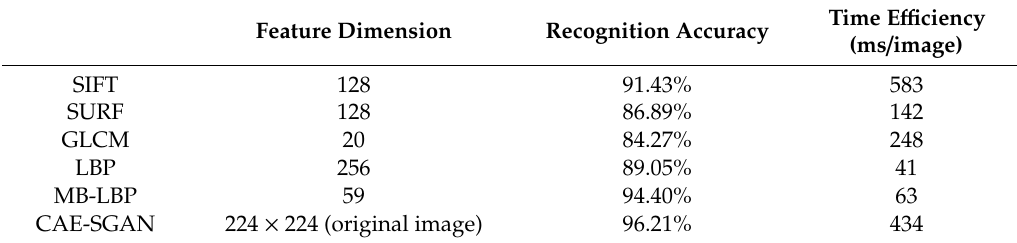
Table 2. Comparison of the recognition accuracy and time e ffi ciency between the MB-LBP and other